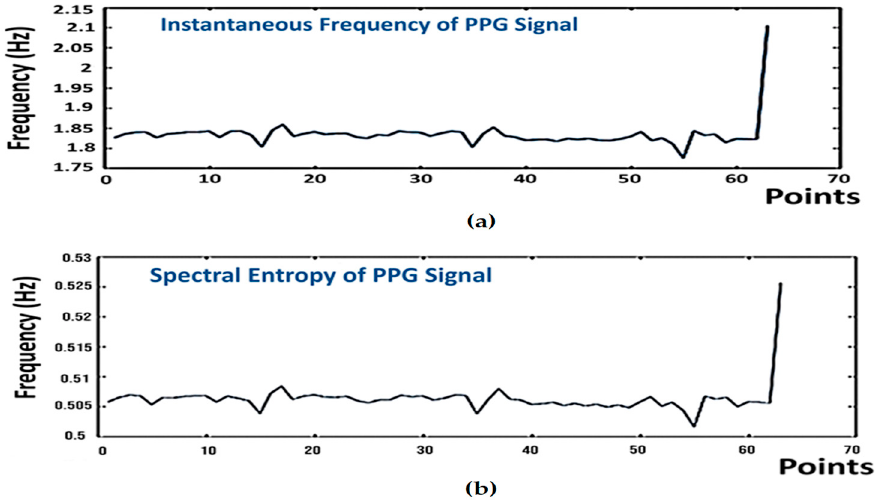
Figure 19. IF and SE signals in diabetic individuals: ( a ) IF PPG signal; ( b ) SE PPG signal.